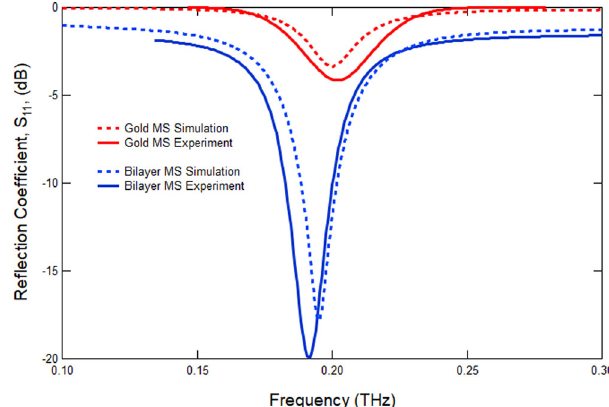
Fig. 4 Comparison of experimental and simulated devices. Experimentally measured S 11 parameters (solid lines) of the unbiased gold-only (red) and graphene/gold bilayer (blue) metasurfaces compared to the simulation results (dashed